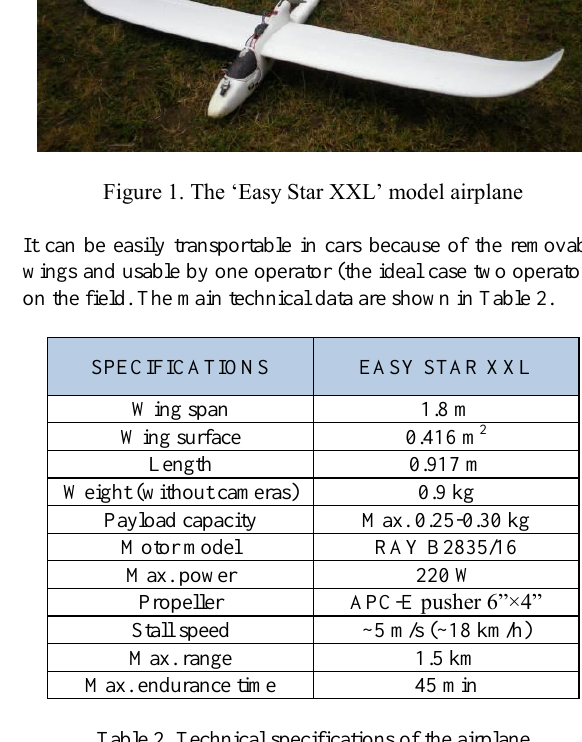
Table 2. Technical specifications of the